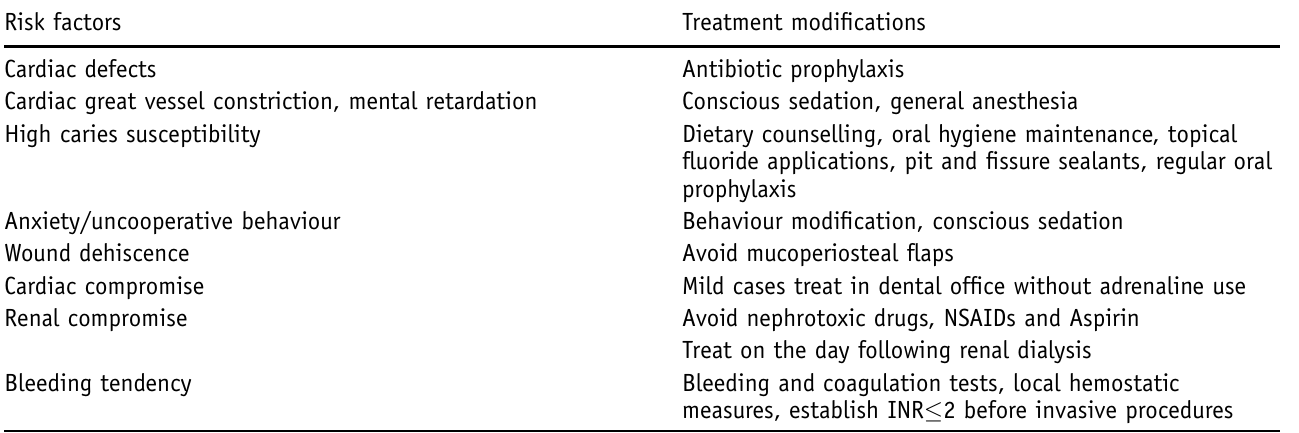
Table IV. Risk factors for oral healthcare and speci fi c treatement modi fi cations